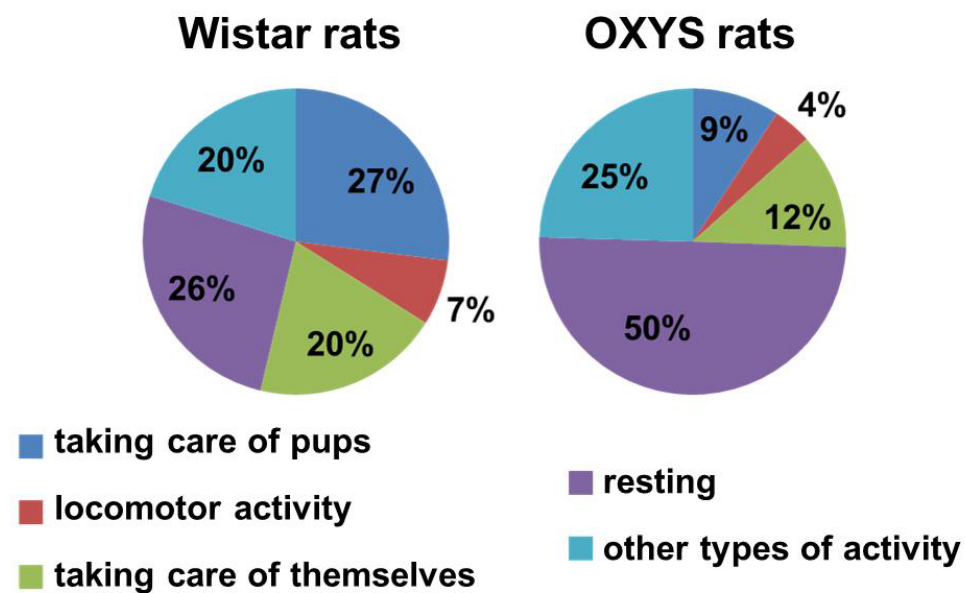
Figure 2. Maternal behavior of OXYS and Wistar rats.